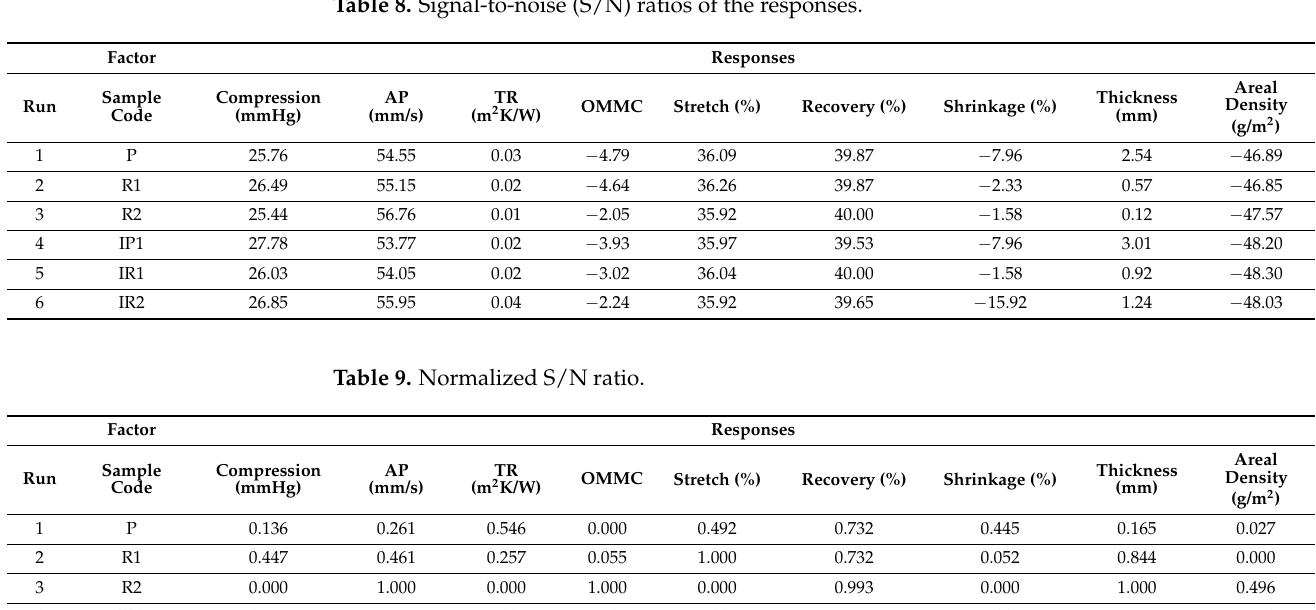
Table 8. Signal-to-noise (S/N) ratios of the responses.